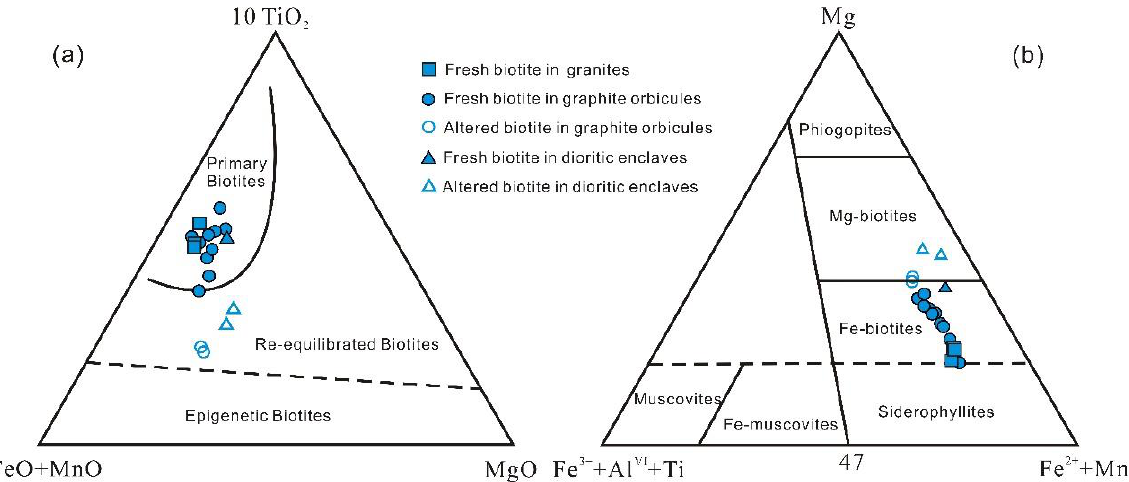
Figure 7. ( a ) Ternary 10 × TiO 2 – (FeO + MnO) – MgO discrimination diagram of primary, re-equili- brated, and epigenetic biotite (after [60]). ( b ) Ternary Mg – (Fe 2+ + Mn) – (Al VI + Fe 3+ + Ti) classification diagram of biotite (after [61]). equilibrated, and epigenetic biotite (after [60]). ( b ) Ternary Mg–(Fe classification diagram of biotite (after